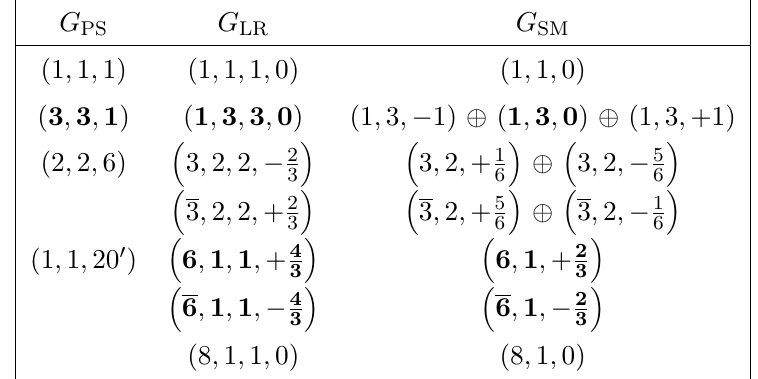
Table 9 . Decomposition for the representation 54 of SO(10) under G PS , G LR , and G SM . We highlight the representations relevant to the discussion in the main text in bold.